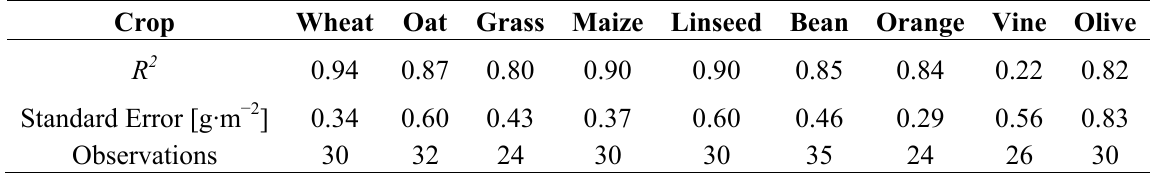
Table 5. Coefficient of determination ( R 2 ), standard error and number of observations